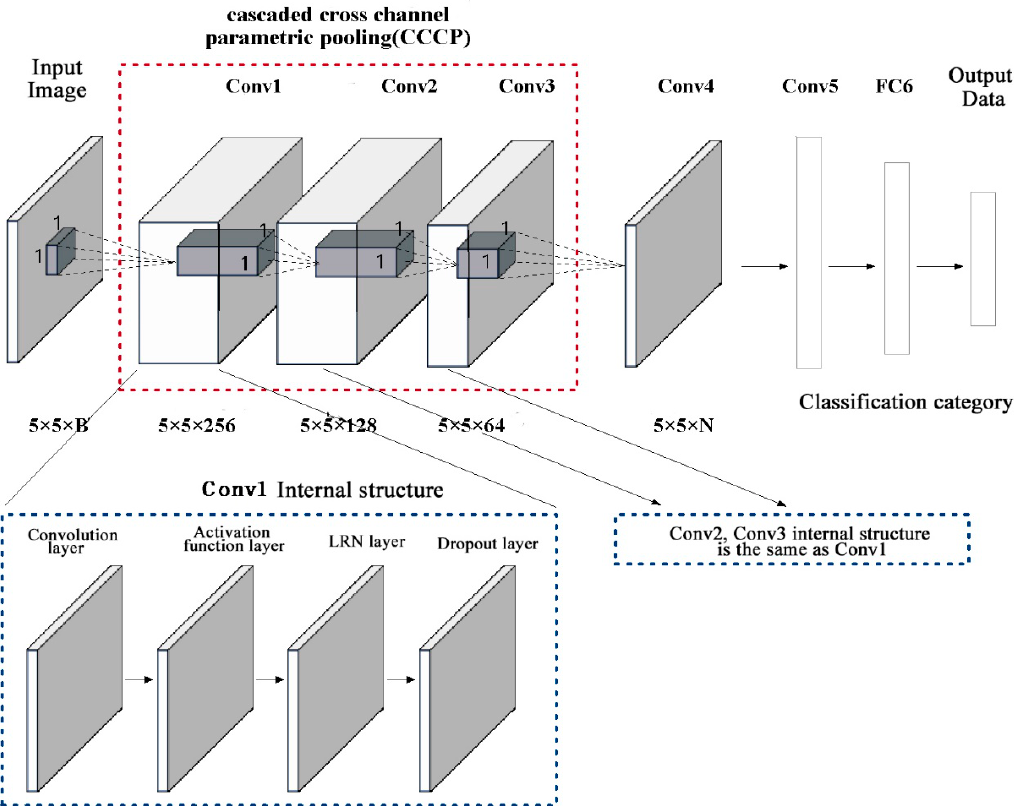
Figure 4. A convolutional neural network model with the the cascaded cross-channel parametric pooling (CCCP) layer (modified from reference [22]).